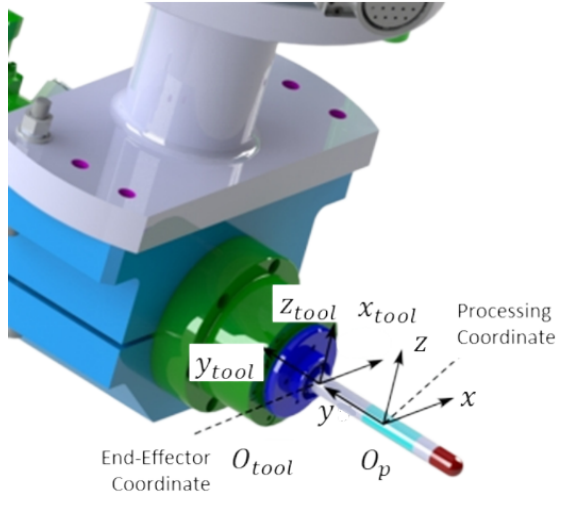
Figure 12. The tool coordinate